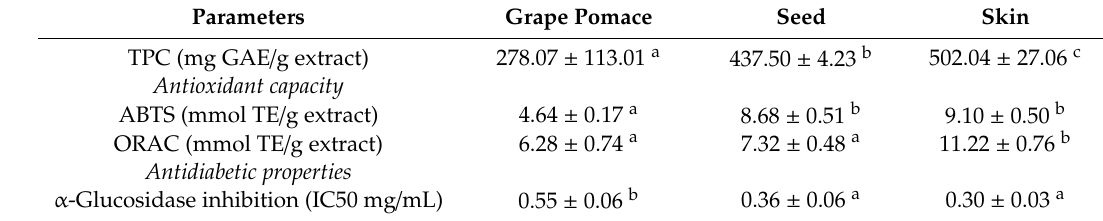
Table 1. TPC, antioxidant capacity and antidiabetic properties of winery byproduct